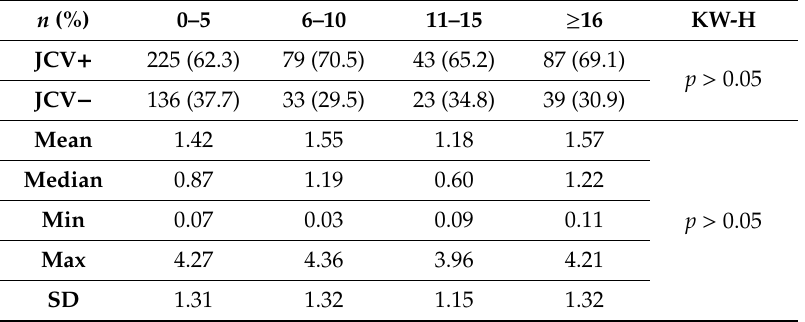
Table 3. Anti-JCV antibody prevalence and antibody index by disease duration